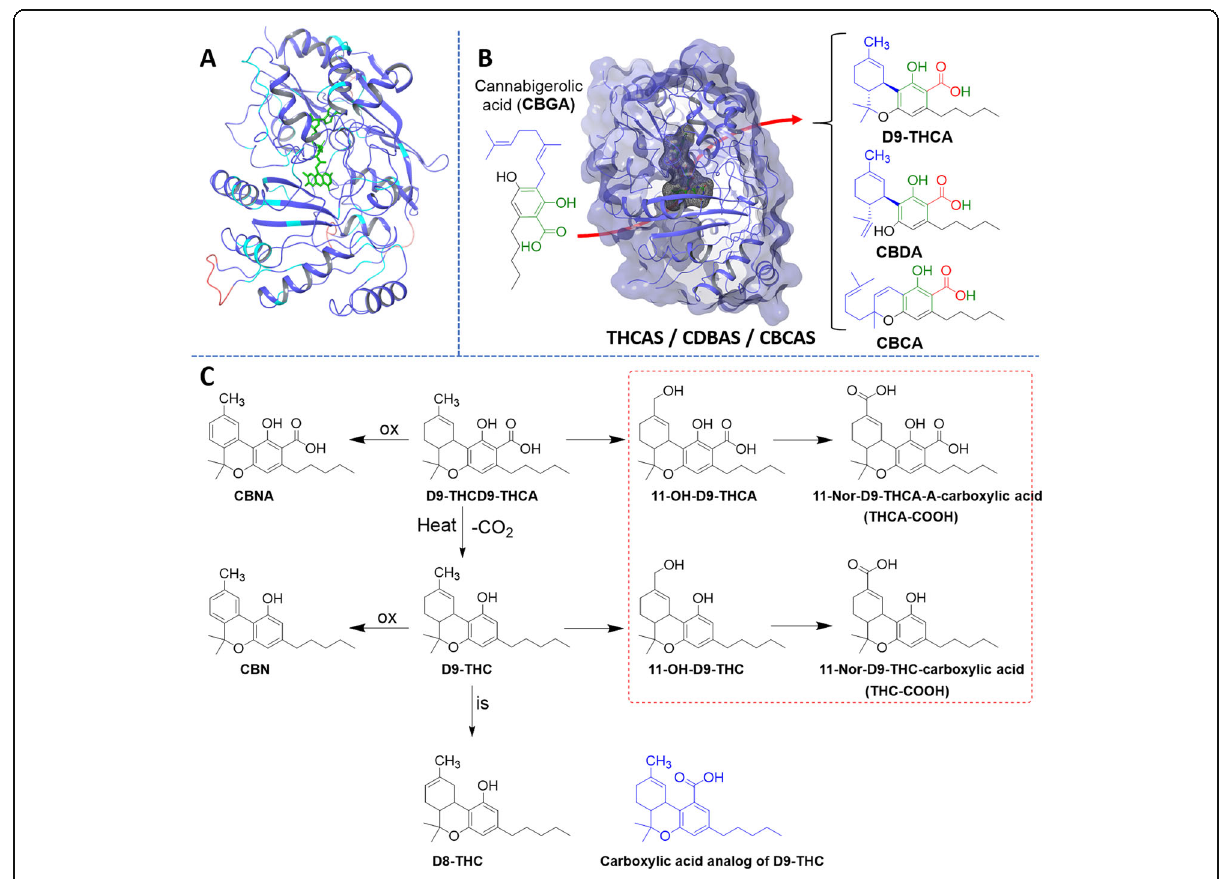
Fig. 6 Comparison of cannabidiolic acid synthase (CBDAS) and tetrahydrocannabinolic acid synthase (THCAS) and the metabolism of cannabinoids. a Homology model of CBDAS developed from THCAS ( 3VTE ); residues conserved from THCAS are purple while variant residues are cyan, sequence insertions are red, and FAD is green; b active site of these enzymes highlighted with a cartoon showing conversion to tetrahydrocannabinolic acid (THCA), cannabidiolic acid (CBDA) and cannabichromenic acid (CBCA) from cannabigerolic acid (CBGA); c experimentally demonstrated oxidation (ox) and isomerization (is) reactions and metabolic fates (encircled) for Δ 9 -THCA and Δ 9 -Tetrahydrocannabinol ( Δ 9